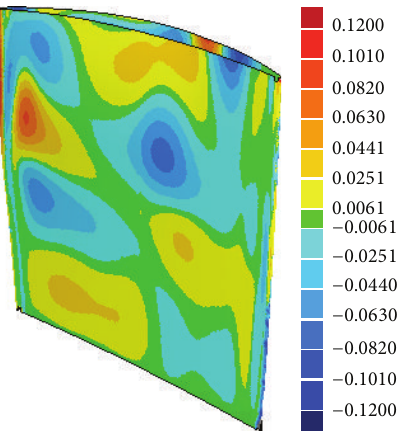
Figure 19: Shape error of the reconstruction model.